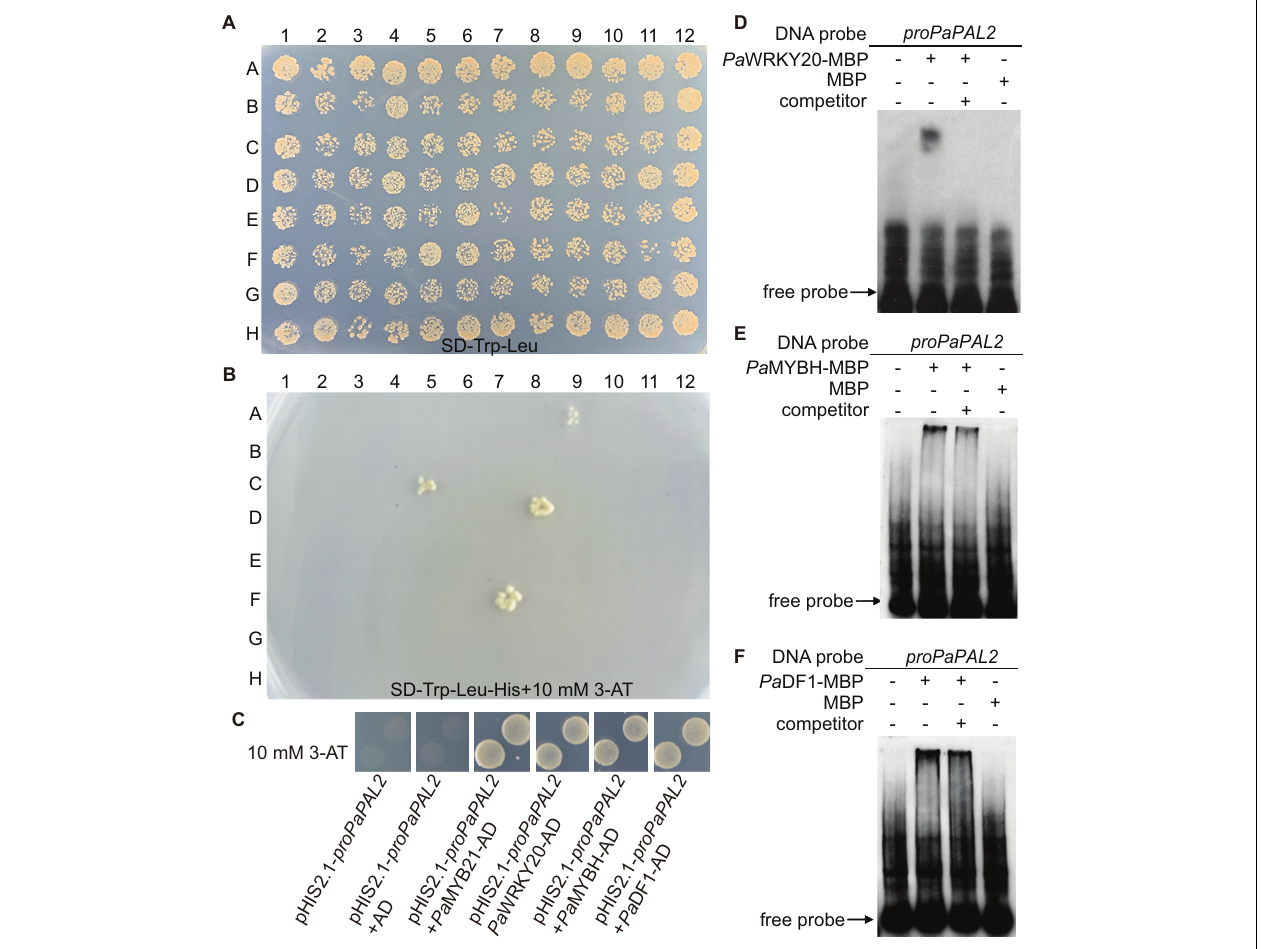
FIGURE 2 | Identification of TFs that bind to the PaPAL2 promoter. (A,B) Y1H screening of the TFs library using 500-bp PaPAL2 promoter fragment as a bait. Yeast growth on the non-selective medium SD-Trp-Leu showed the mating efficiency. The candidate TFs can be detected on medium with 10 mM 3-AT. (C) Y1H assays